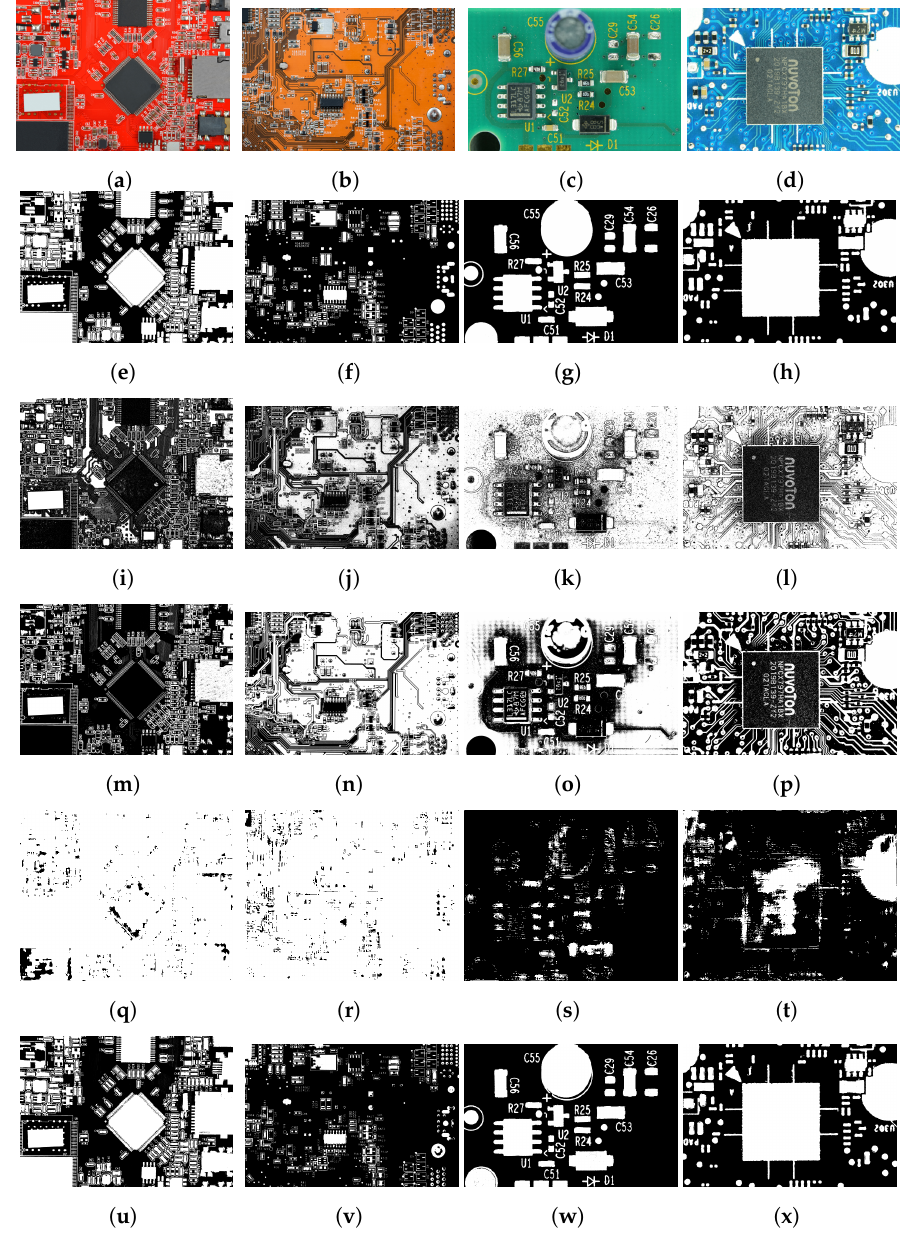
Figure 7. ( a – d ) Sample images of the PCA board dataset with varying background colors and ( e – h ) corresponding ground truth. ( i – l ) Results using Singh et al. [38], ( m – p ) DTP-Net fine-tuned model [46], ( q – t ) U-Net with Resnet-152 as backbone, and ( u – x ) proposed